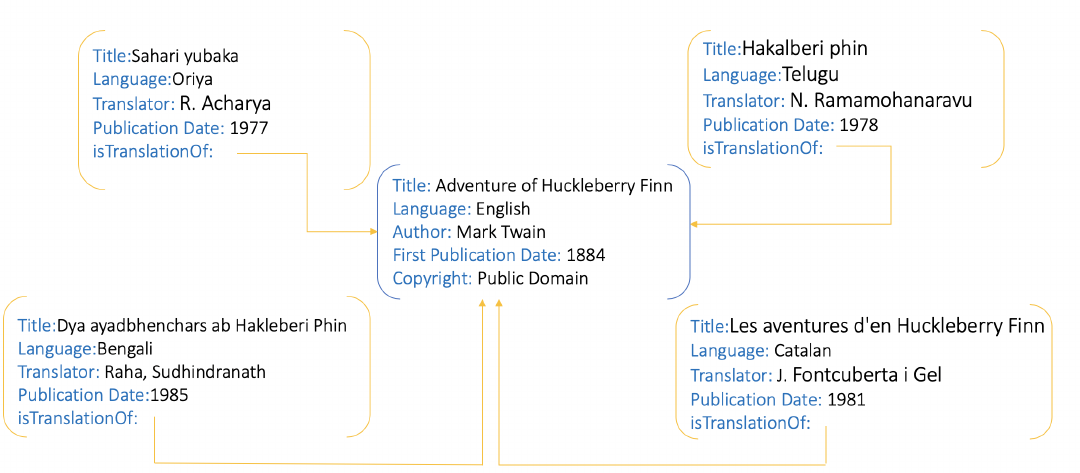
Figure 1. The global knowledge diagram representing a subset of existing translations of Adventures of Huckleberry Finn in four languages.